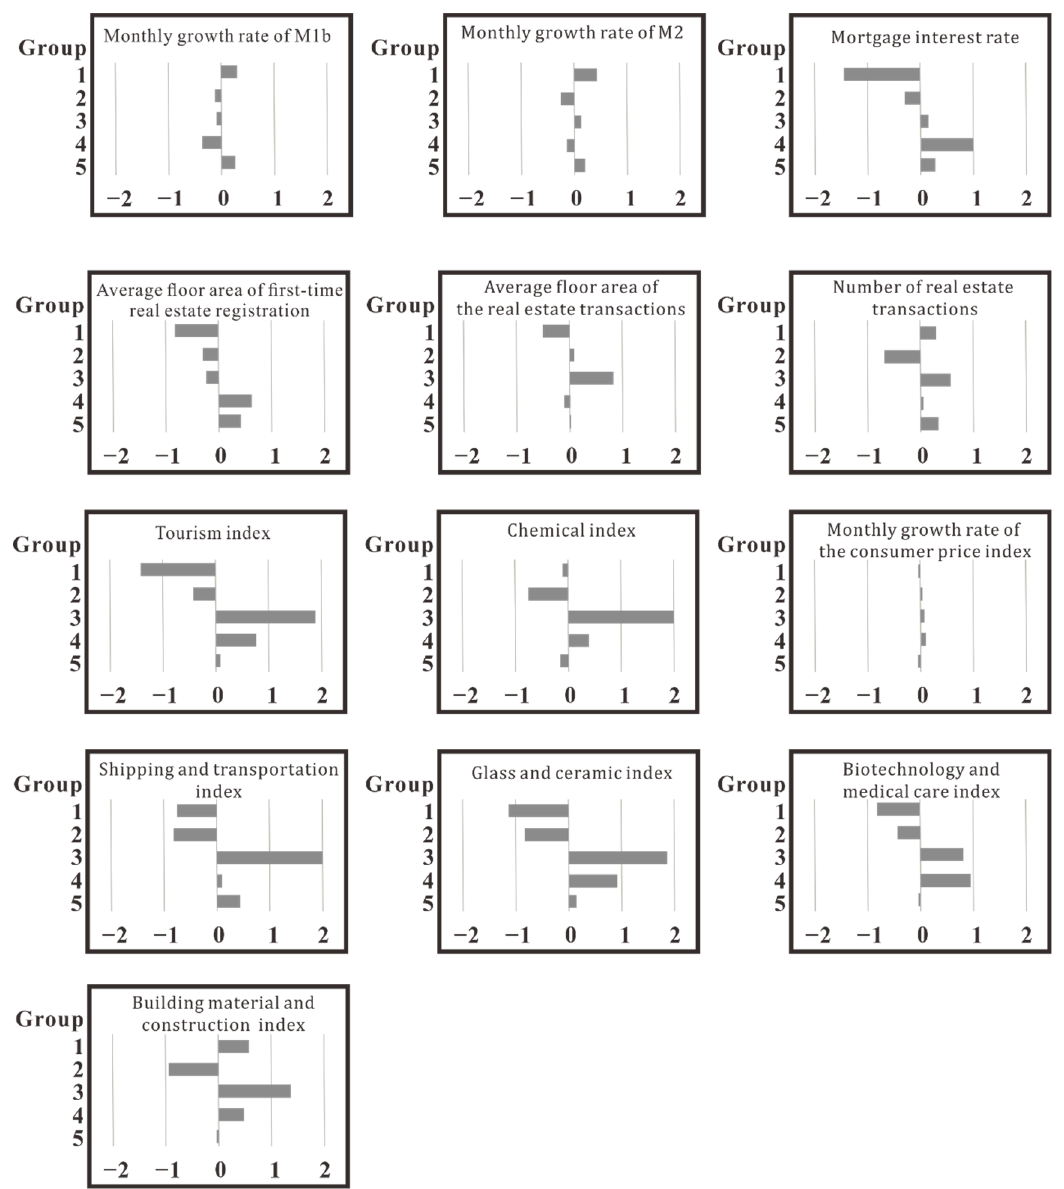
Figure 1. Average value of characters in monthly clustering results related to money supply. Table 1. Descriptive statistics of indexes related to money supply from January 2009 to December